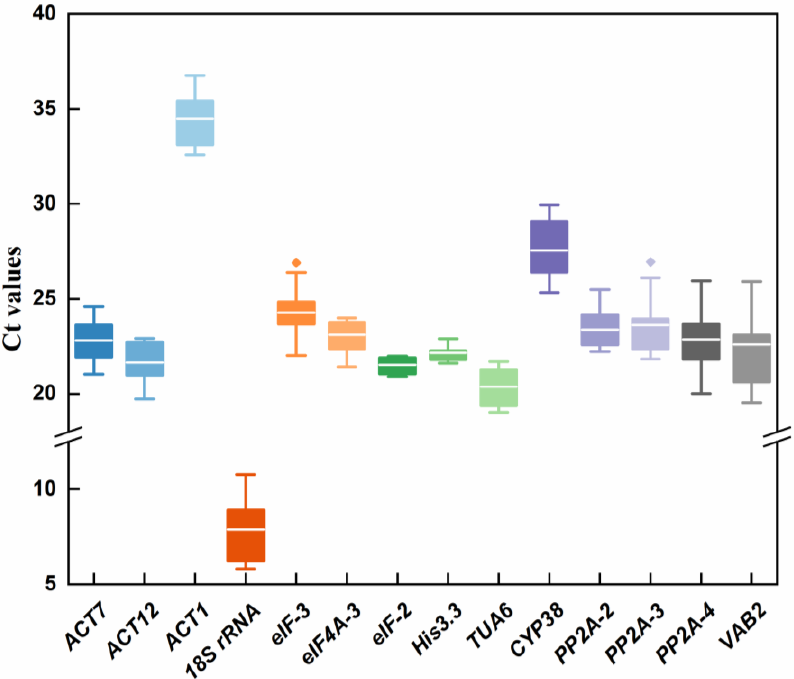
Figure 2. Expression levels of 14 candidate reference genes in all P. vulgaris samples. The box chart indicates the interquartile range. The outer box shows the 25th to 75th percentile, and the inner box indicates the average. Lines across the boxes depict the medians and whiskers represent the maximum and minimum values. The dots represent the outlier.